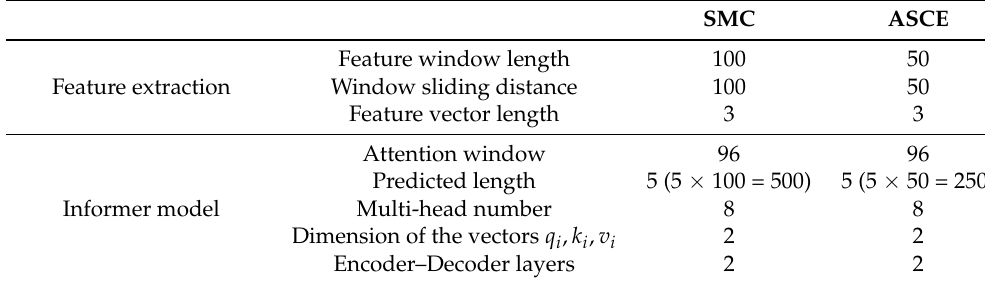
Table 1. Parameter setting of FFT–Informer model.